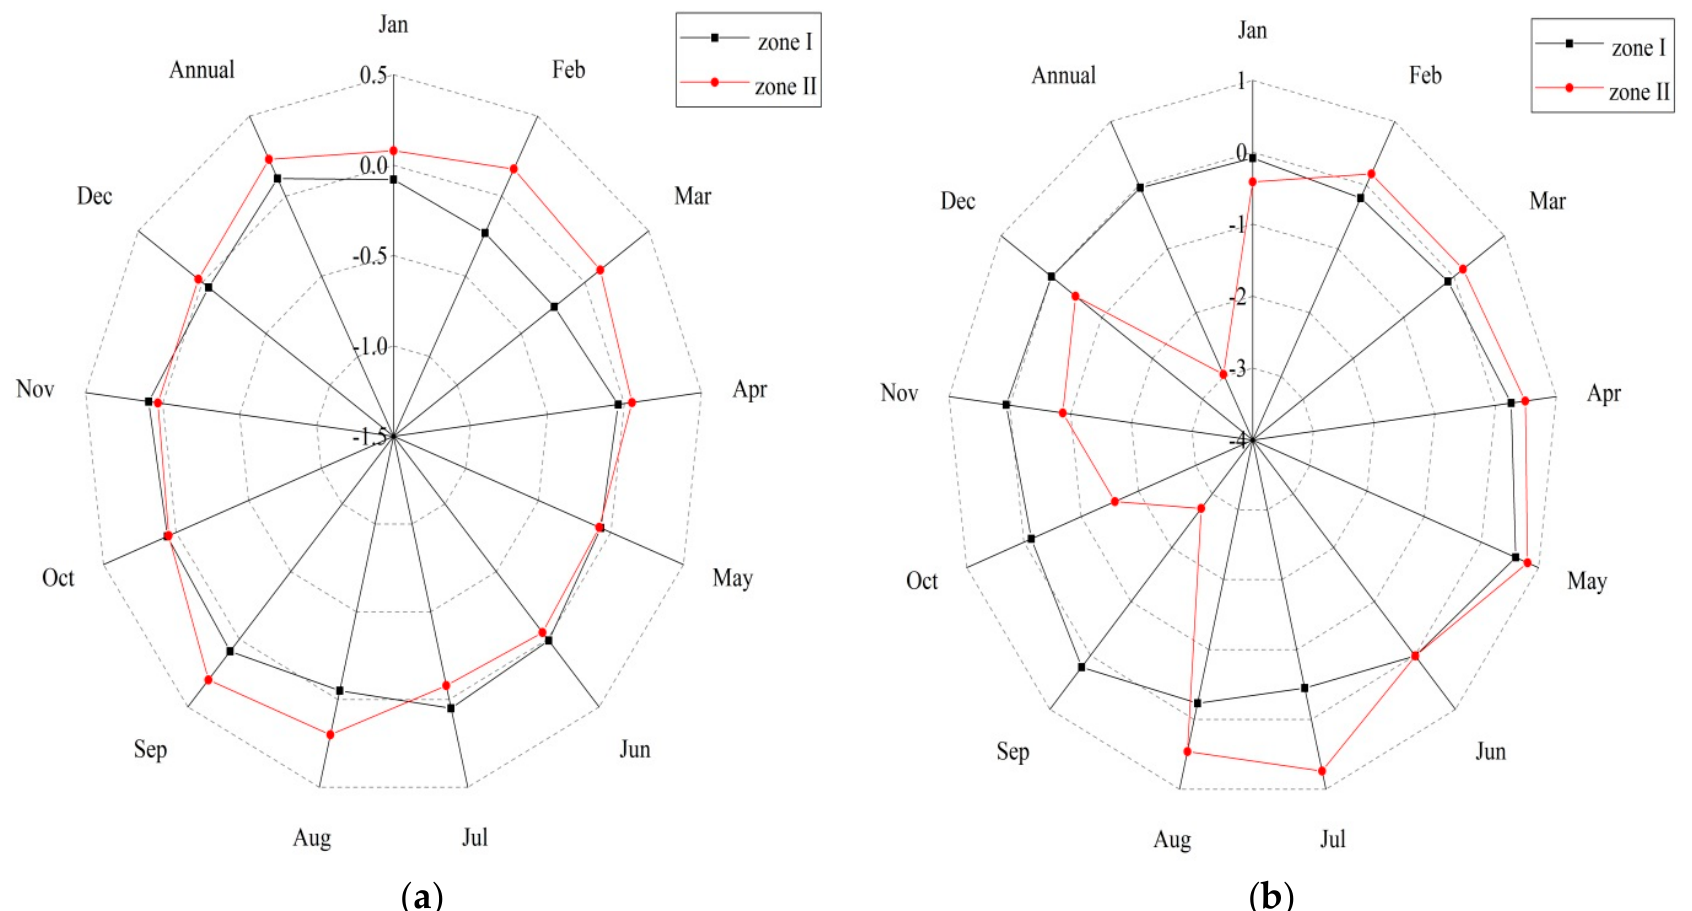
Figure 28. Precipitation and temperature sensitivity in the two zones based on a modified climate-elasticity model. ( a ) Precipitation sensitivity ( b ) temperature sensitivity